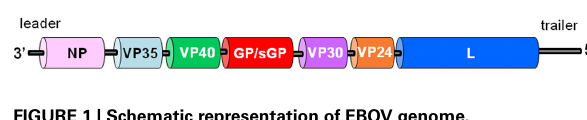
FIGURE 1 | Schematic representation of EBOV genome.